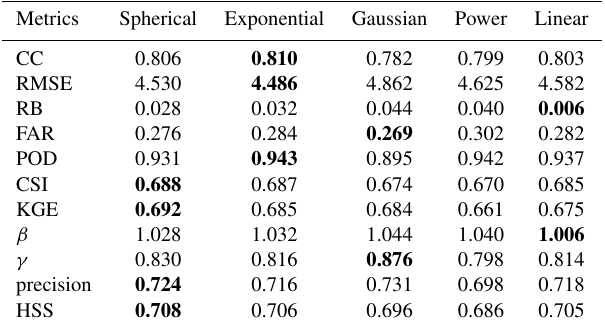
Table B1. The performance of KPs estimated from five